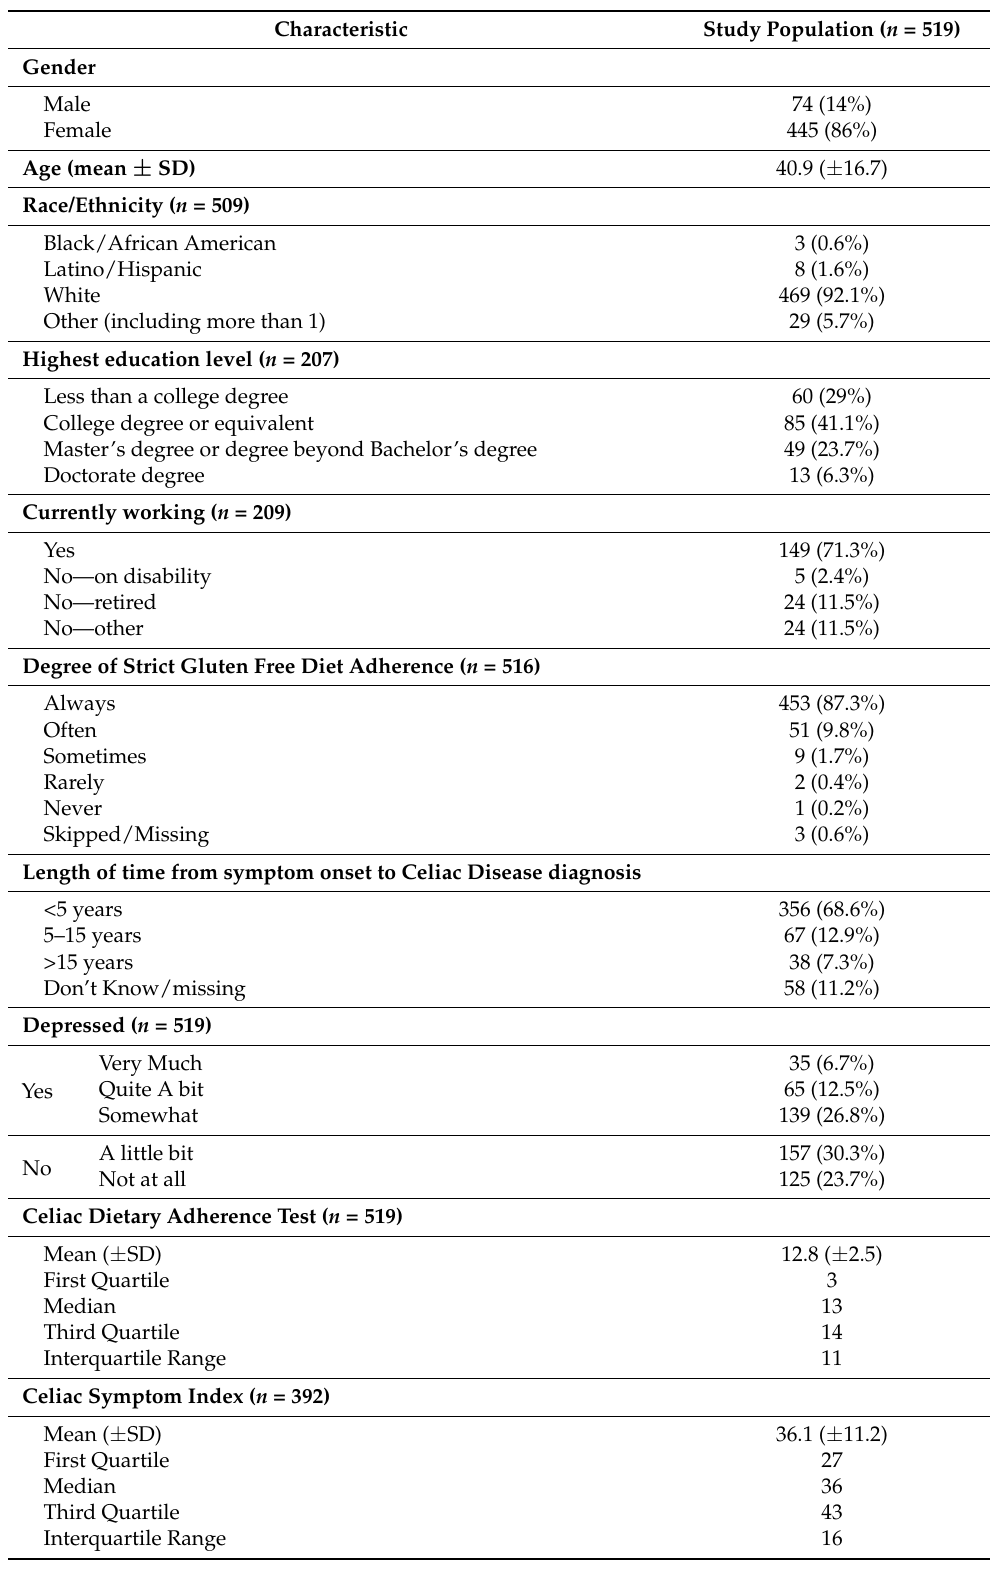
Table 1. Patient characteristics of our study population. As the questionnaire was voluntary, some questions are missing responses from all 519